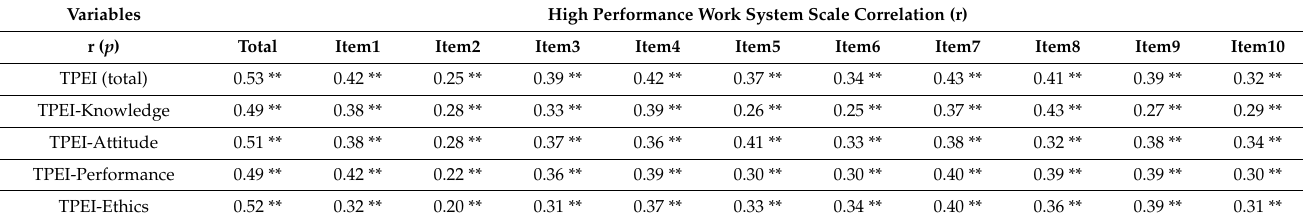
Table 4. Correlation among concurrent variables ( N =